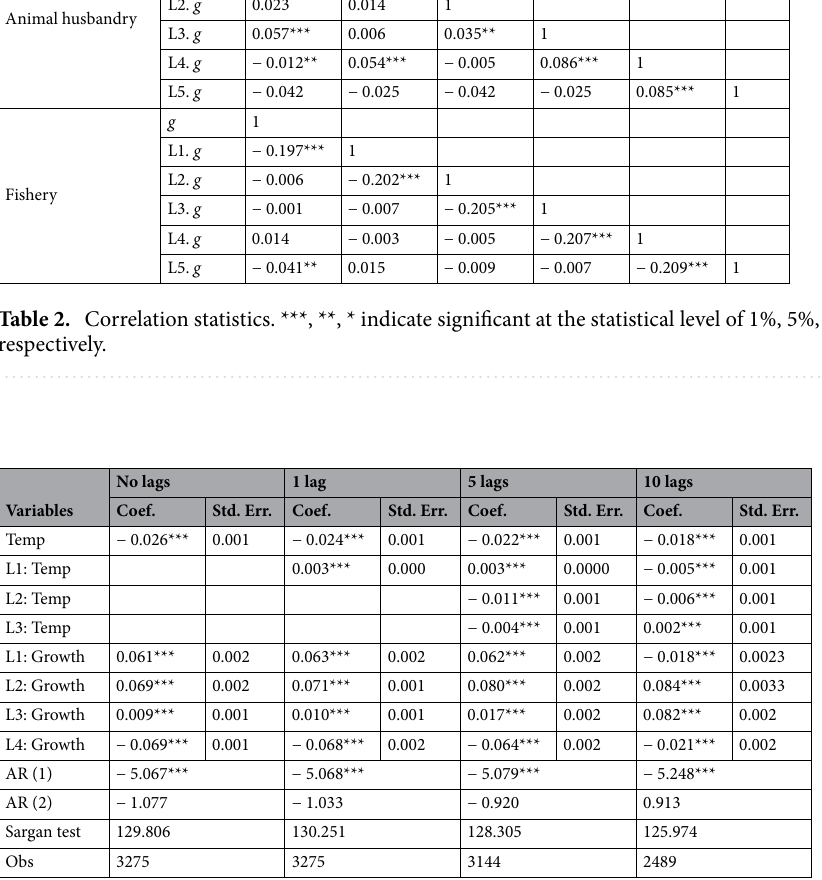
Table 3. Estimated impact of annual average temperature changes on agricultural economic growth. ***, **, * indicate significant at the statistical level of 1%, 5%, and 10%, respectively.